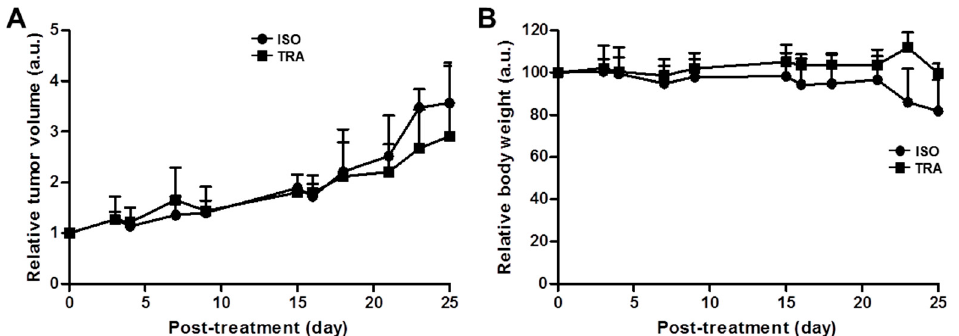
Figure 5. Therapeutic efficacy of trastuzumab in JIMT-1 xenograft model. ( A ) The tumor volumes were measured after injection of rituximab (isotype, ISO) and trastuzumab (TRA) with 10 mg/kg, twice per week for 4 weeks. Tumor volume was calculated by long diameter × (short diameter) 2 /2, and ( B ) Body weight was measured thrice a week. No apparent body weight loss was observed in all groups during treatment.